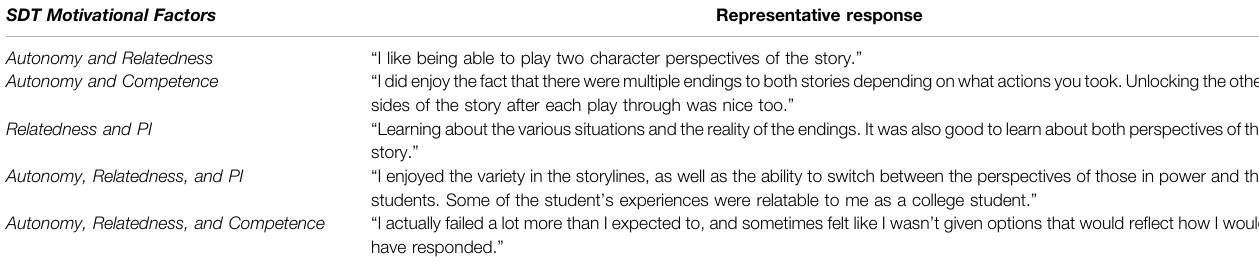
TABLE 4 | Examples of responses that contained more than one SDT factor (PI =